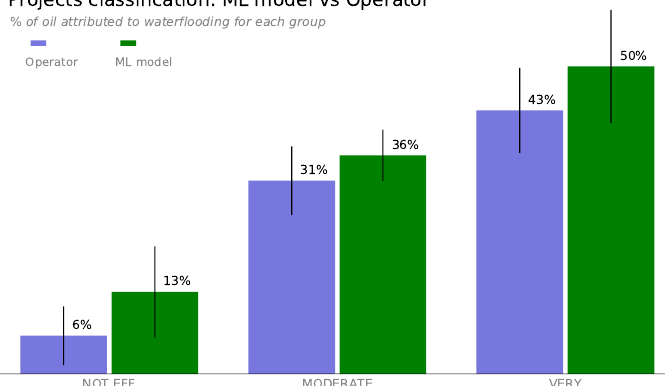
Figure 8. Chart shows percentage of oil attributed to waterflooding within groups. The green bars are related to the ML model classification. The blue bars are related to the operator’s classification. The height of a bar reflects the average percentage of oil attributed to waterflooding for a related group by 50 train/test partitions. The black error bars indicate + − standard